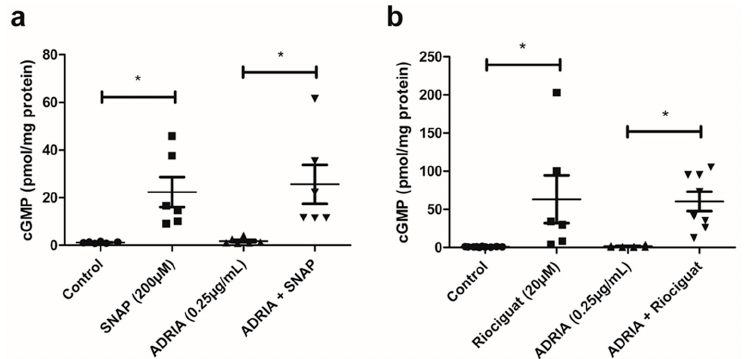
Figure 2. Riociguat and SNAP stimulate cGMP synthesis. ( a ) hPOD were incubated with 200 µ M of the NO donor SNAP or ( b ) with 20 µ M of the sGC stimulator Riociguat for 15 min and cGMP production was measured. Incubation was performed in the absence or presence of 0.25 µ g/mL Adriamycin to mimic podocyte injury. * p < 0.05.